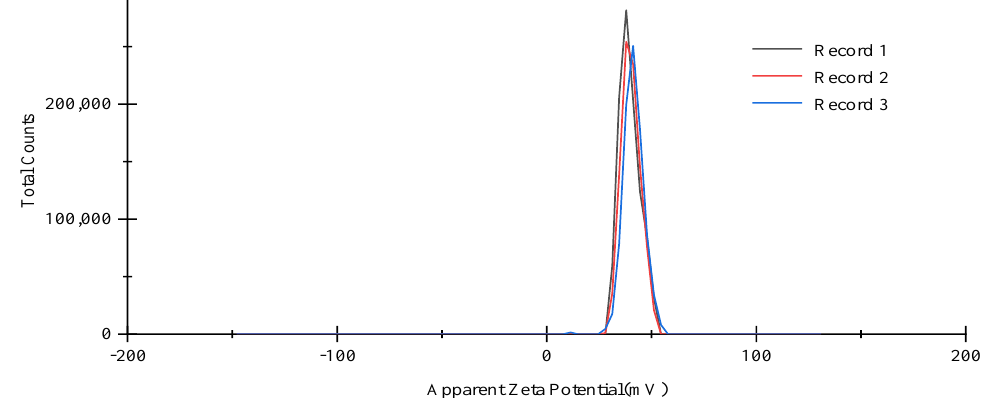
Figure 3. Particle size of OEO-CSNPs. Records 1 − 3 represent the first few repetitions of the experiment.